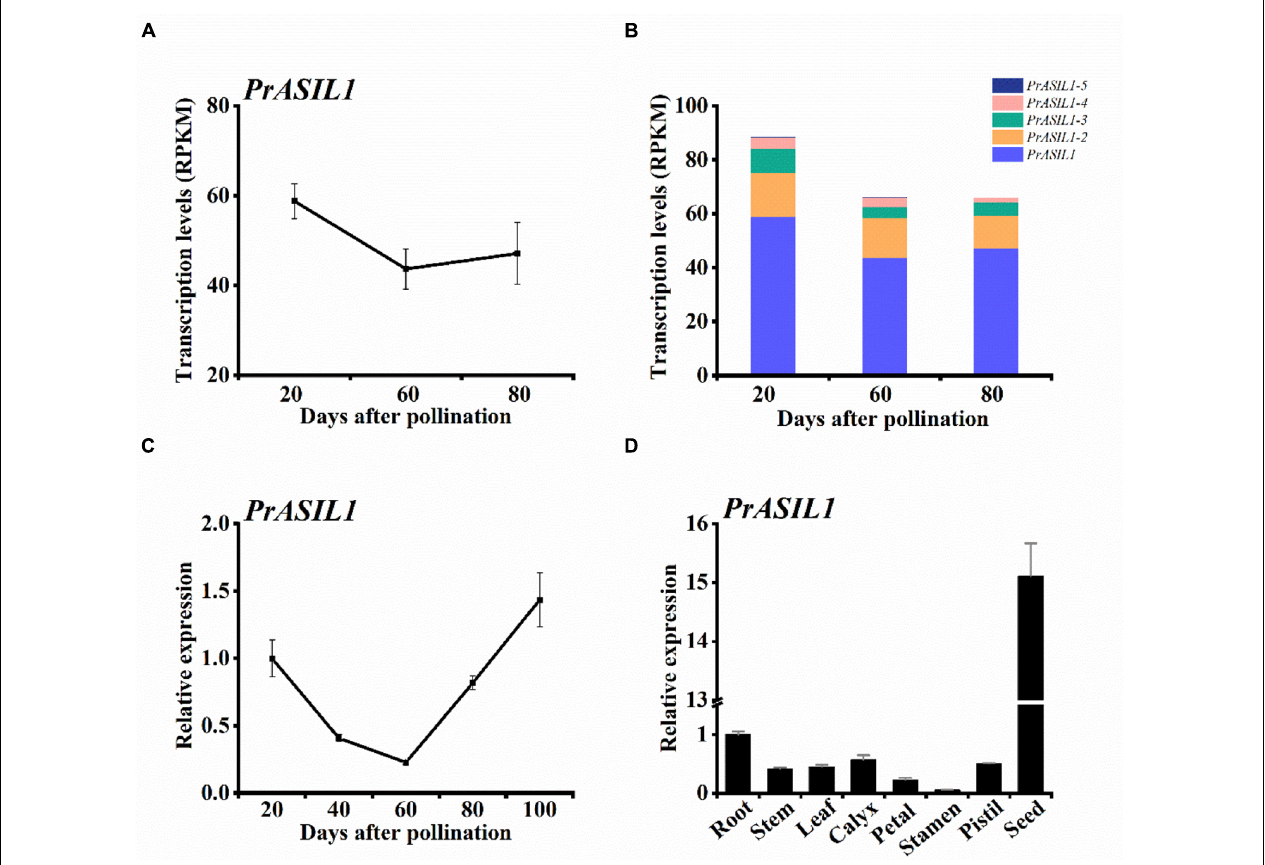
FIGURE 1 | PrASIL1 is highly expressed in developing seeds of P. rockii . (A) PrASIL1 transcript levels in developing seeds. (B) Comparison of transcript levels of all PrASIL1 paralogs in developing seeds. (C) Expression pattern of PrASIL1 in developing seeds of P. rockii and (D) PrASIL1 expression in various tissues of P. rockii . Values are mean ± SD ( n =